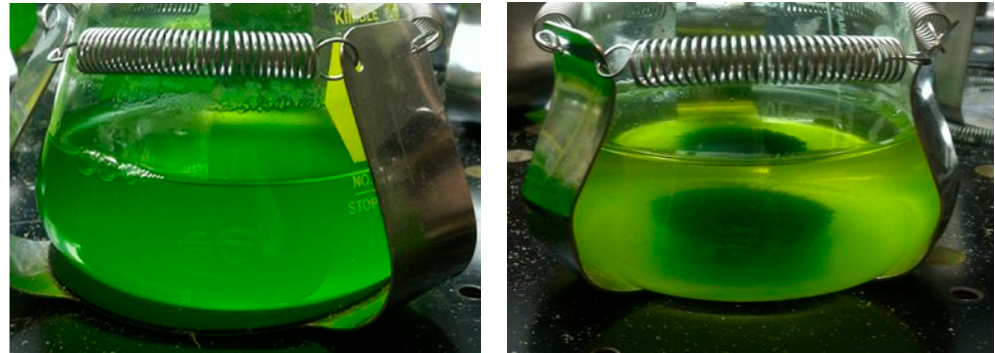
Figure 4. Before ( left ) and after ( right ) photos of a C. kessleri pond crash by B . calyciflorus .